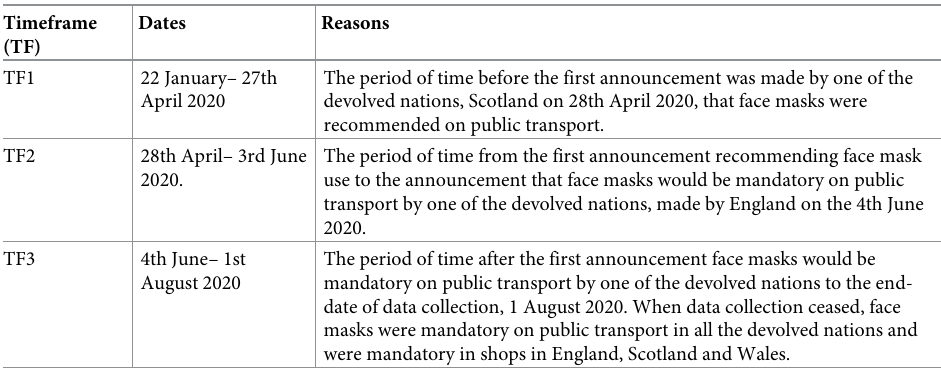
Table 3. Timeframes used for